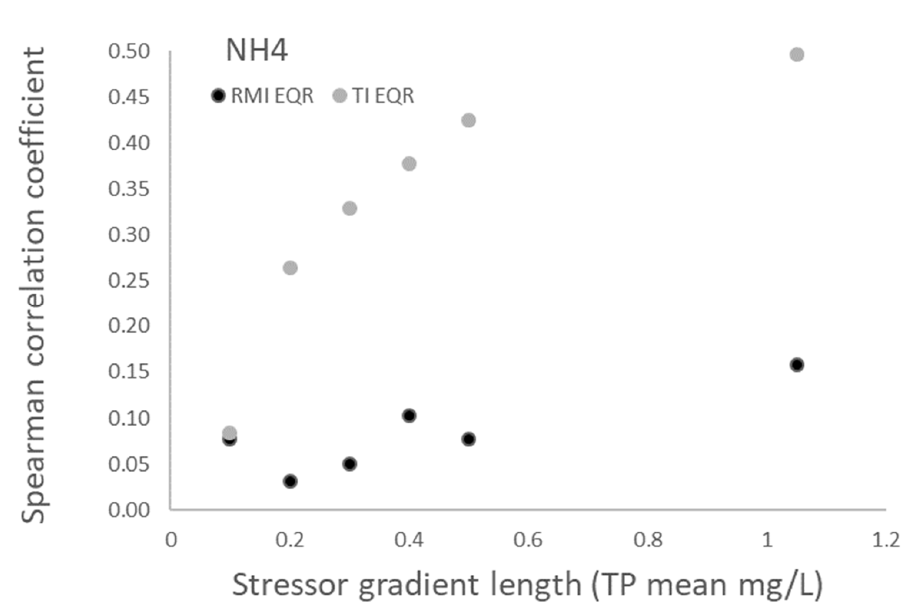
Figure 5. Changes in the correlation coefficient (R) between the ammonium—maximum values (NH4 max) and River Macrophyte Index (RMI EQR) and Trophic Index (TI EQR), respectively, as a function of the stressor gradient length expressed as the total phosphorous—annual mean value (TP mean).